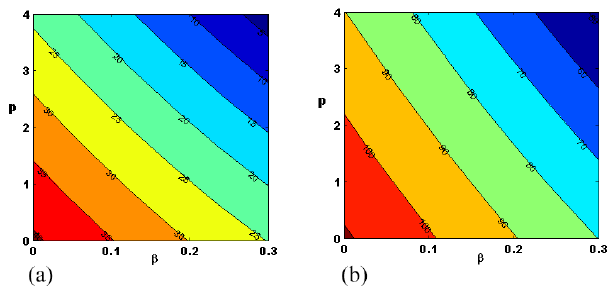
Figure 5. Contour plot of q 1 with respect to p and β with µ = 0 . 1, (a) SS, (b) CS.